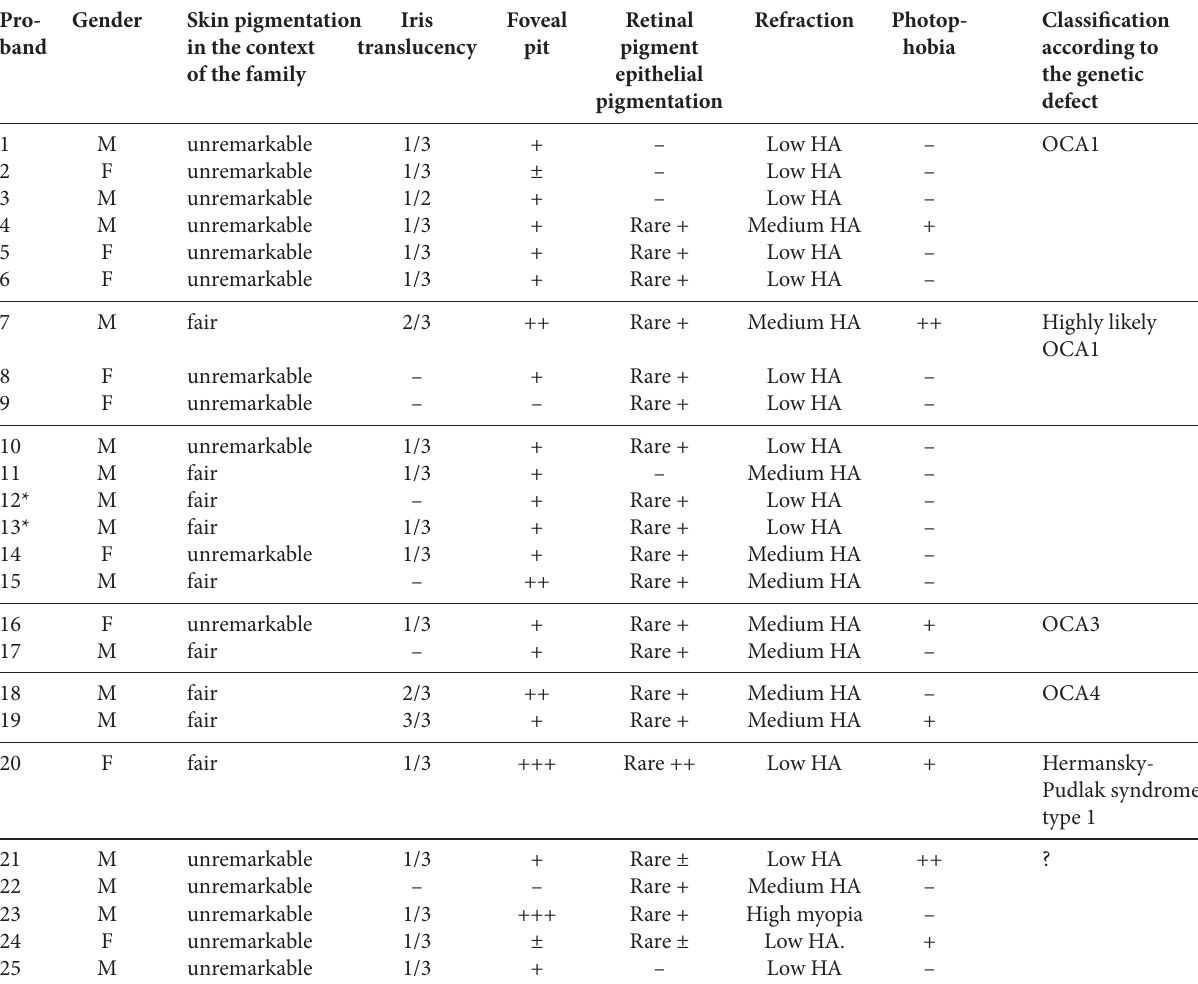
Table 1: Clinical finding in children with suspected OCA. M-male, F-female. Iris translucency : – not present; 1/3 one third; 2/3 two thirds; 3/3 total . Foveal pit : ± underdeveloped; + minimal foveal depression; ++ absent; +++ no foveal depression, choroidal vessels seen at the posterior pole and foveal area. Retinal pigmentepithelial pigmentation : – changes not evident; ± rare, abnormal periphery; rare +, choroidal vessels seen at the posterior pole, but not in the foveal area; rare ++, choroidal vessels seen also in the foveal area. Refraction: HA – hypermetropic astigmatism, low